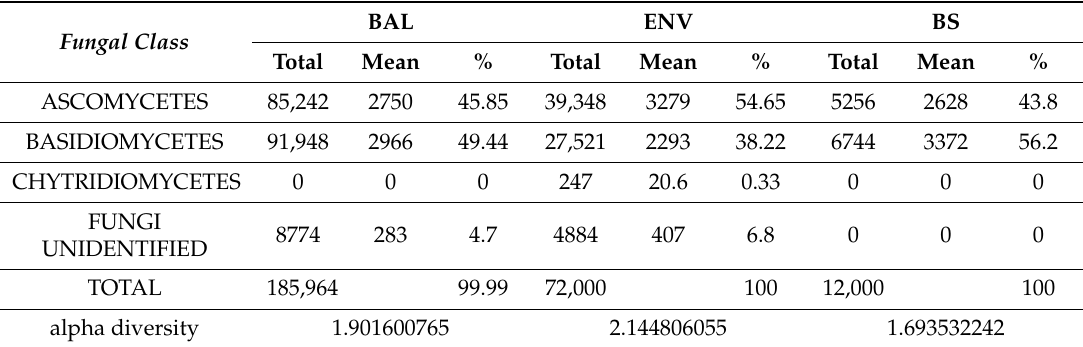
Figure 3. Distribution of OTUs at a phylum level in each BAL, BS, and ENV samples. Upper blue arrows point at BS samples. Table 3. Distribution of sequences of the three classes of fungi and alpha diversity (mean value of Shannon-Wiener index) by the type of sample after rarefaction.